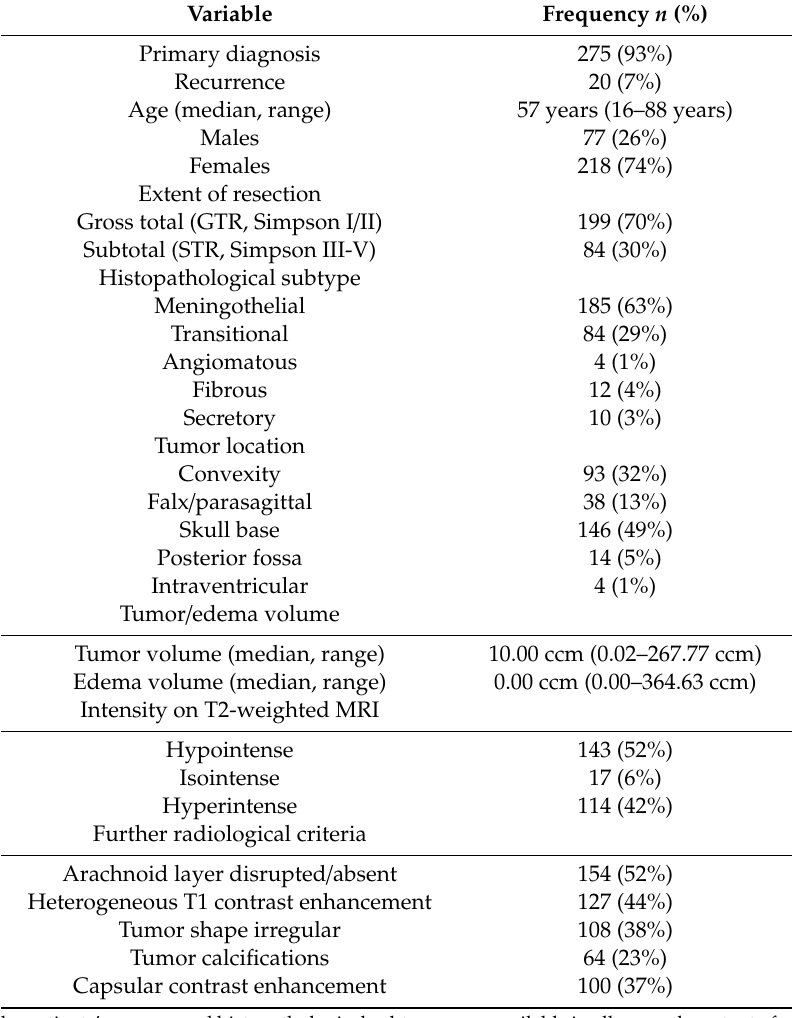
Table 1. Baseline clinical and histopathological